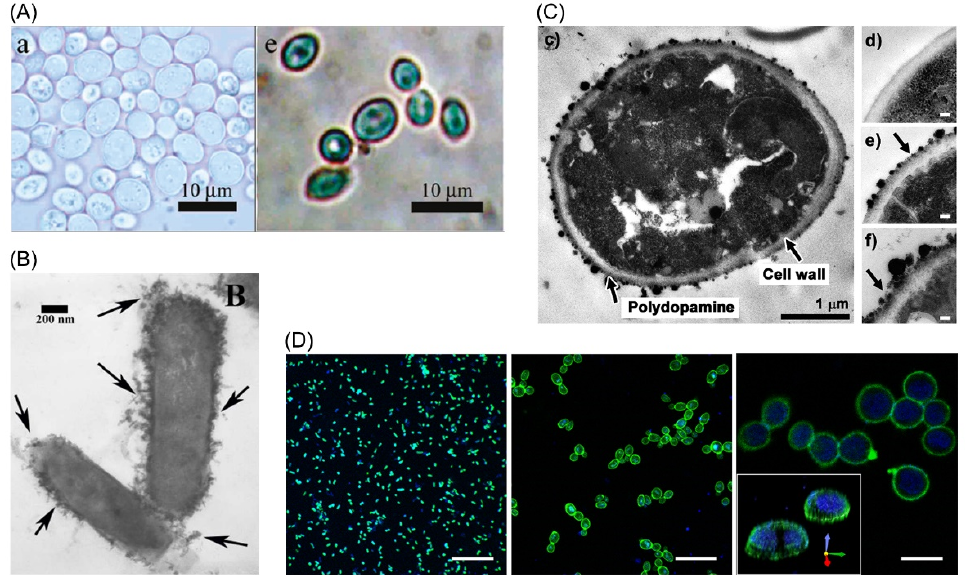
Figure 3. LbL cell encapsulation with atypical methodologies. ( A ) Optical imaging of uncoated yeasts and yeasts coated with Ag nanoparticles. Adapted with permission [116]. Copyright 2009, American